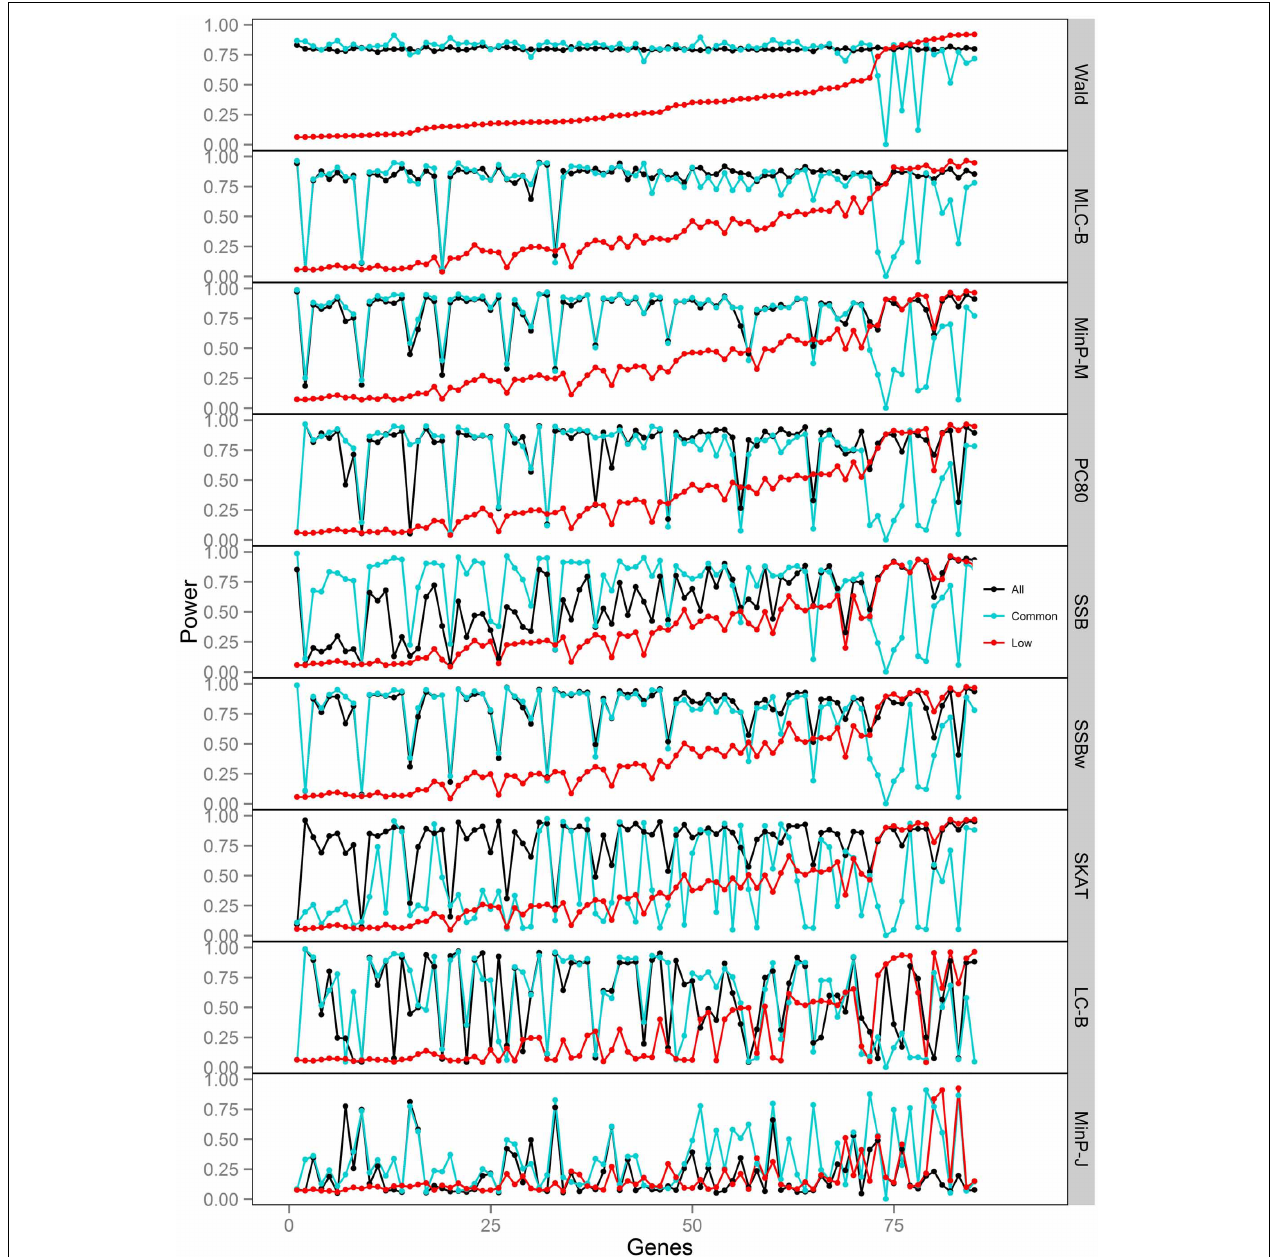
FIGURE 7 | Power of gene-based tests using three analysis sets of SNPs for 85 genes under trait Model 5. Genes are ordered along the horizontal axis according to the empirical power of Wald test using only low frequency